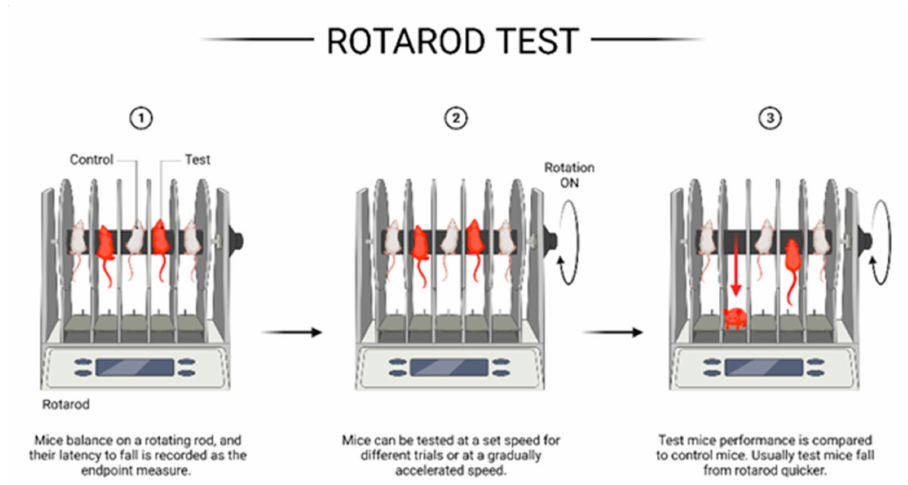
Figure 1. Schematic illustration of the rotarod setup and test principle. Created with BioRender.com (accessed on 14 August